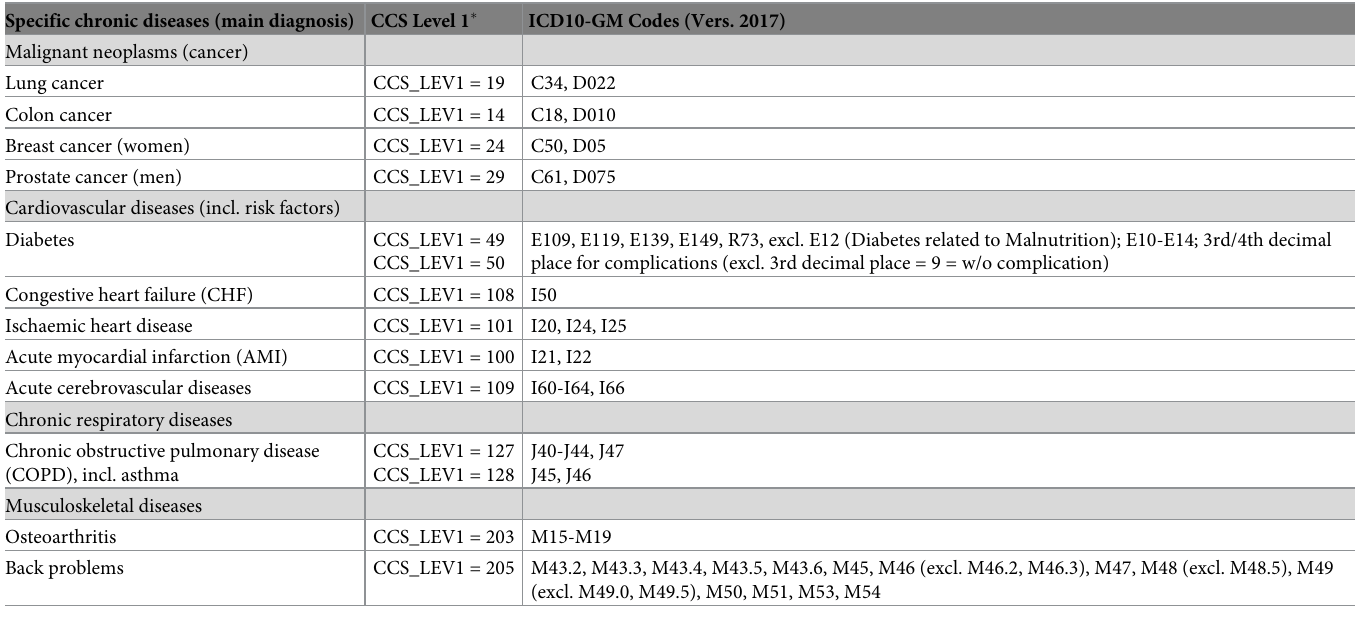
Table 1. Definition of chronic health